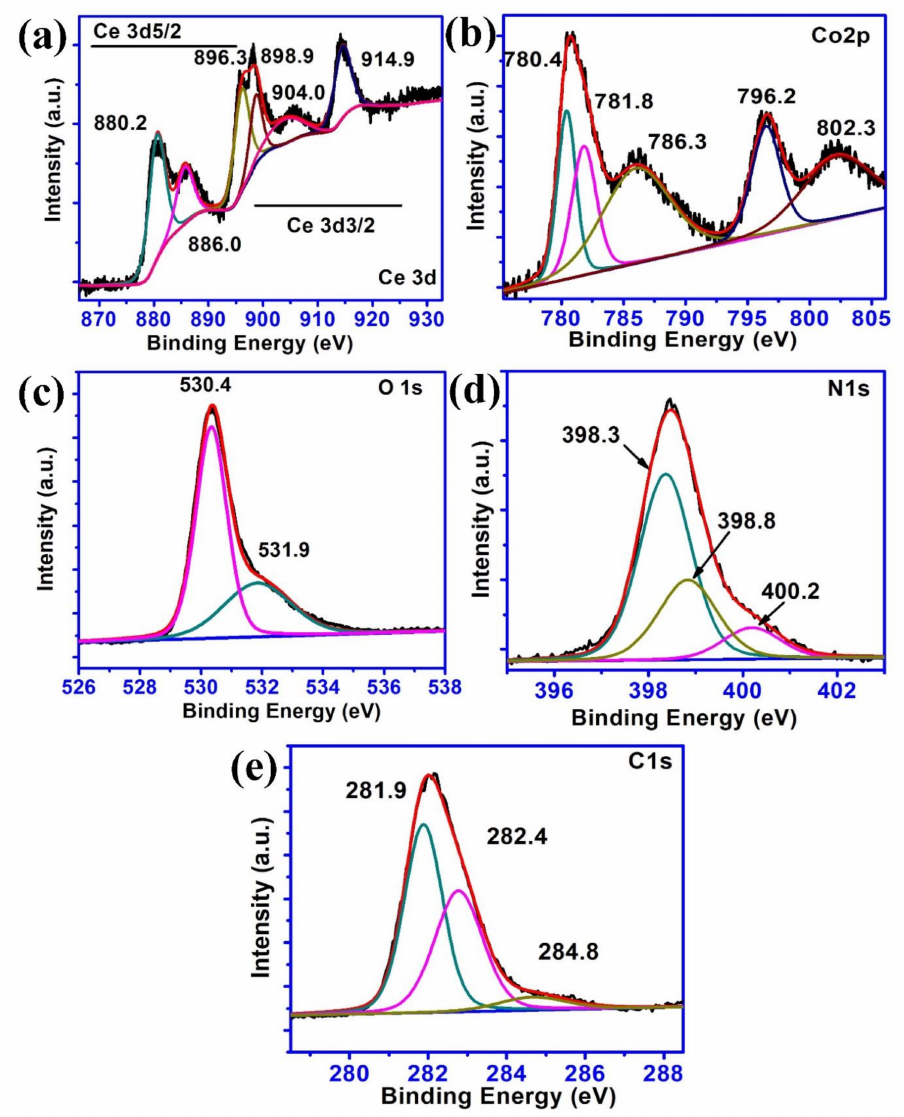
Figure 5. The XPS spectra of ZIF-67/CeO 2 ( a ) Ce 3d ( b ) Co 2p ( c ) O 1s ( d ) N1s ( e ) C 1s. The porosity and specific surface area of the samples which can affect catalytic per- formance were carefully examined by nitrogen adsorption–desorption isotherm measure- ments for ZIF-67 and CeO 2 as shown in Figure